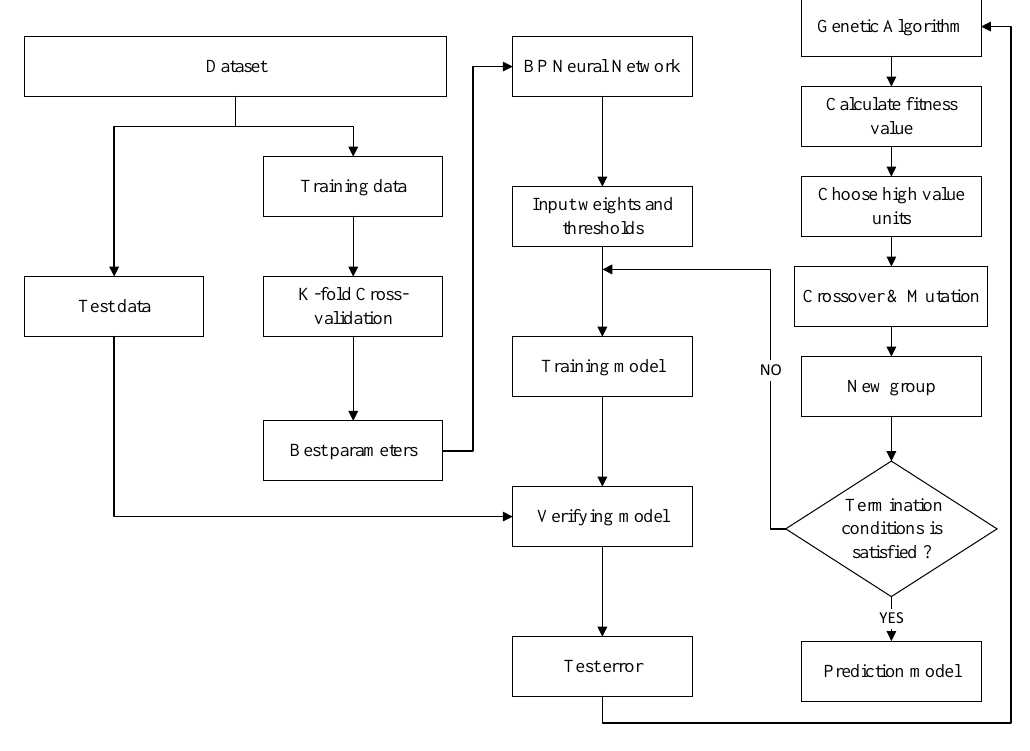
Figure 4. Flow chart of BP neural network optimized by K-fold cross-validation.